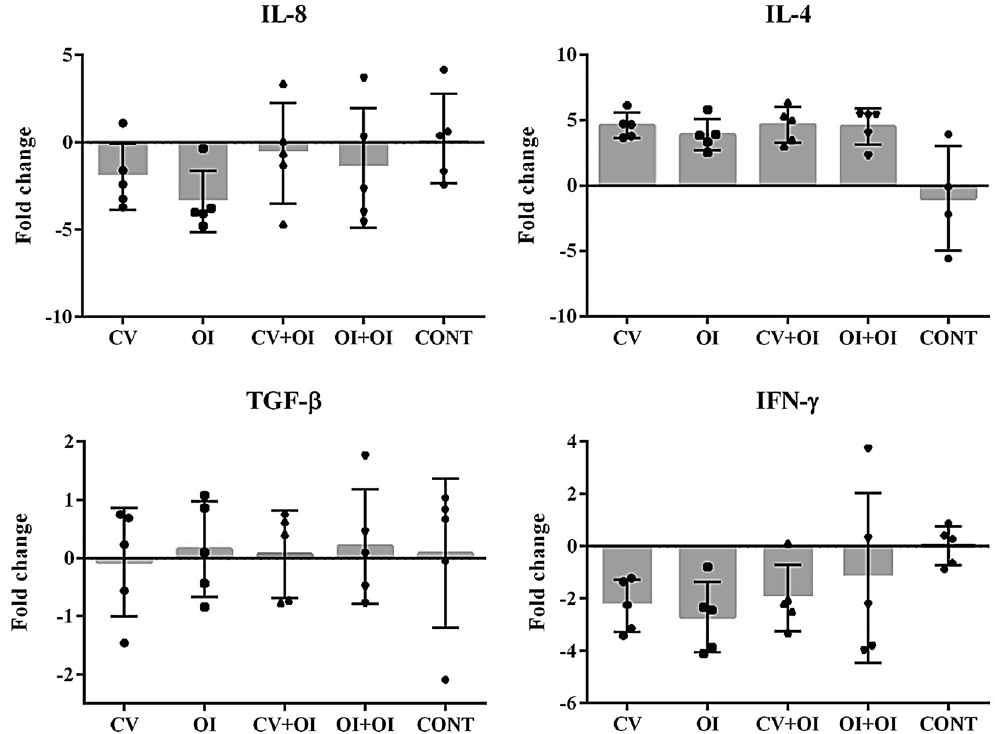
Figure 5. Bar graphs representing the fold change of cytokine gene expression (Fold Change mean ± sd) in lung lesion samples of five pigs per group, 28 days after experimental infection with M. hyopneumoniae strain 232, previously submitted to different immunization protocols. Target gene expression was normalized based on rpl- 4 gene expression. No statistical differences were found between groups (Kruskall-Wallis